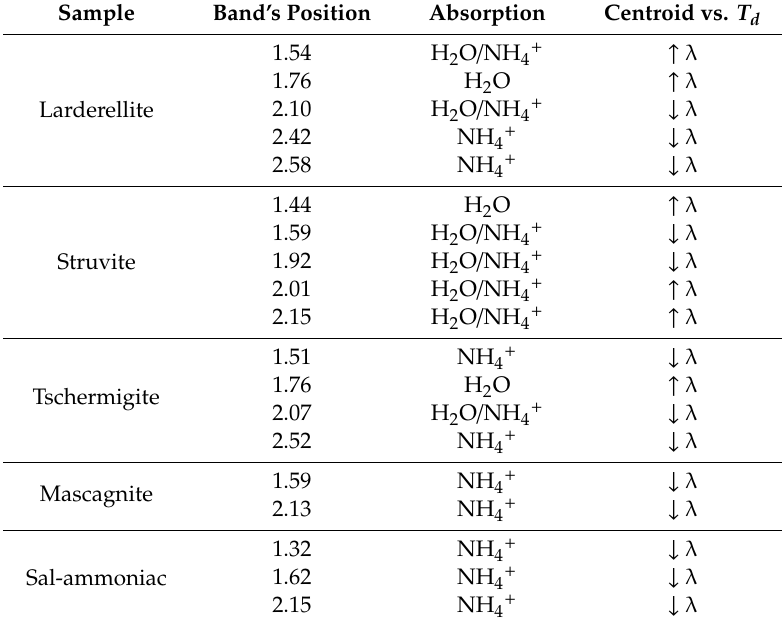
Table 4. Band parameters’ variation (centroid = bend center) at decreasing temperature for the analyzed spectral features in the range until 3 µ